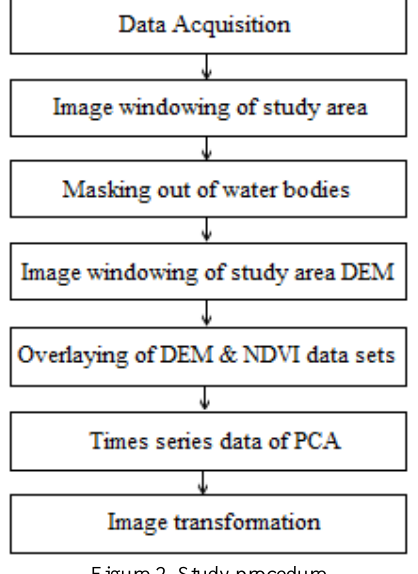
Figure 2. Study procedure